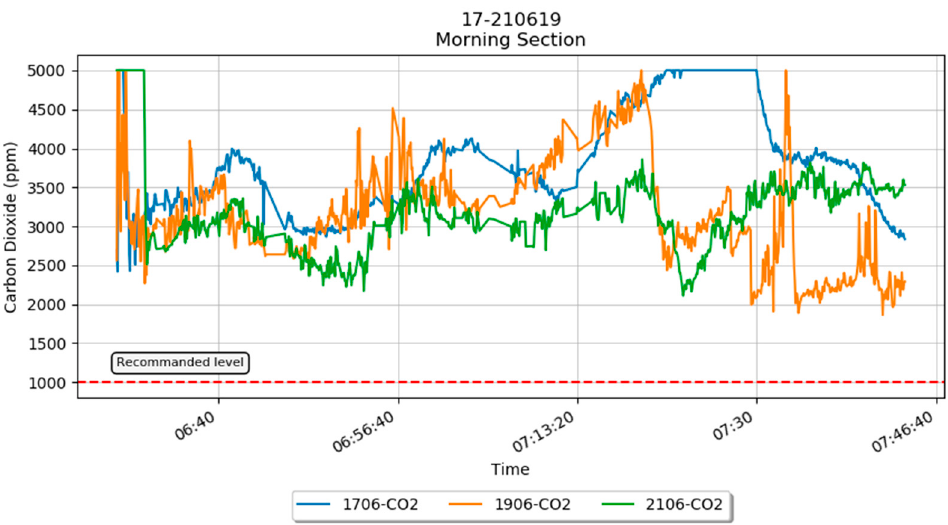
Figure 5. The raw carbon dioxide sensor data plotted for the morning slot. Table 2. Data features and samples size for the in-vehicle air